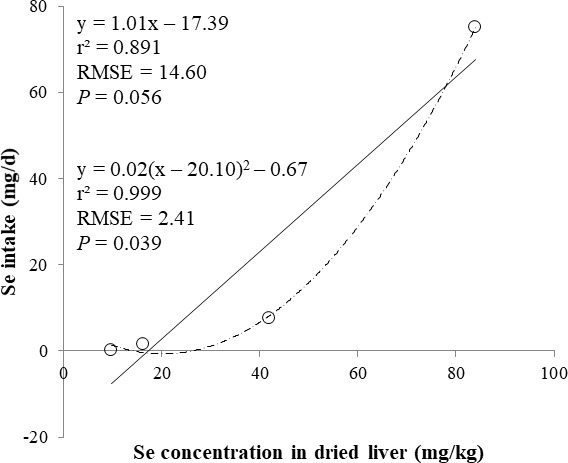
Linear and quadratic regression equations for estimating daily selenium (Se) intake (mg/d) based on Se concentration in dried liver (mg/kg).Each data point represents least squares mean of four observations. r2, coefficient of determination; RMSE, root mean square of error.